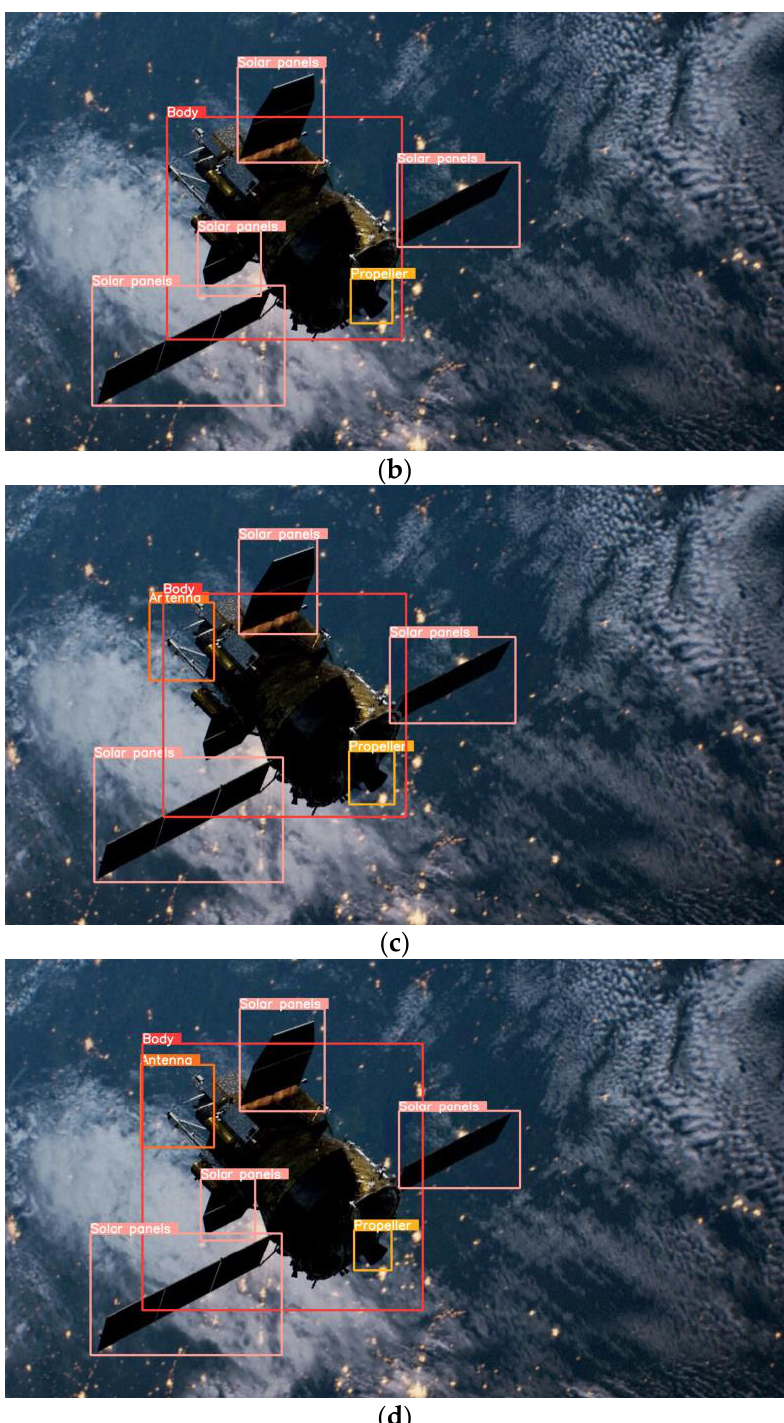
Figure 10. The experimental results of the comparison method under partially shadowed conditions. ( a ) YOLOv5-MobileNetv3 detection results. ( b ) YOLOv5-ShuffleNetv2 detection results. ( c ) YOLOv5- GhostNet detection results. ( d ) YOLOv5-GMB detection